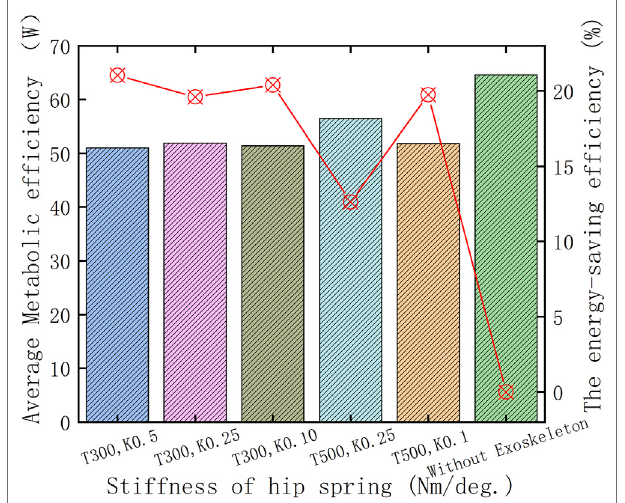
FIGURE 11 | Torque changes of the knee torsion